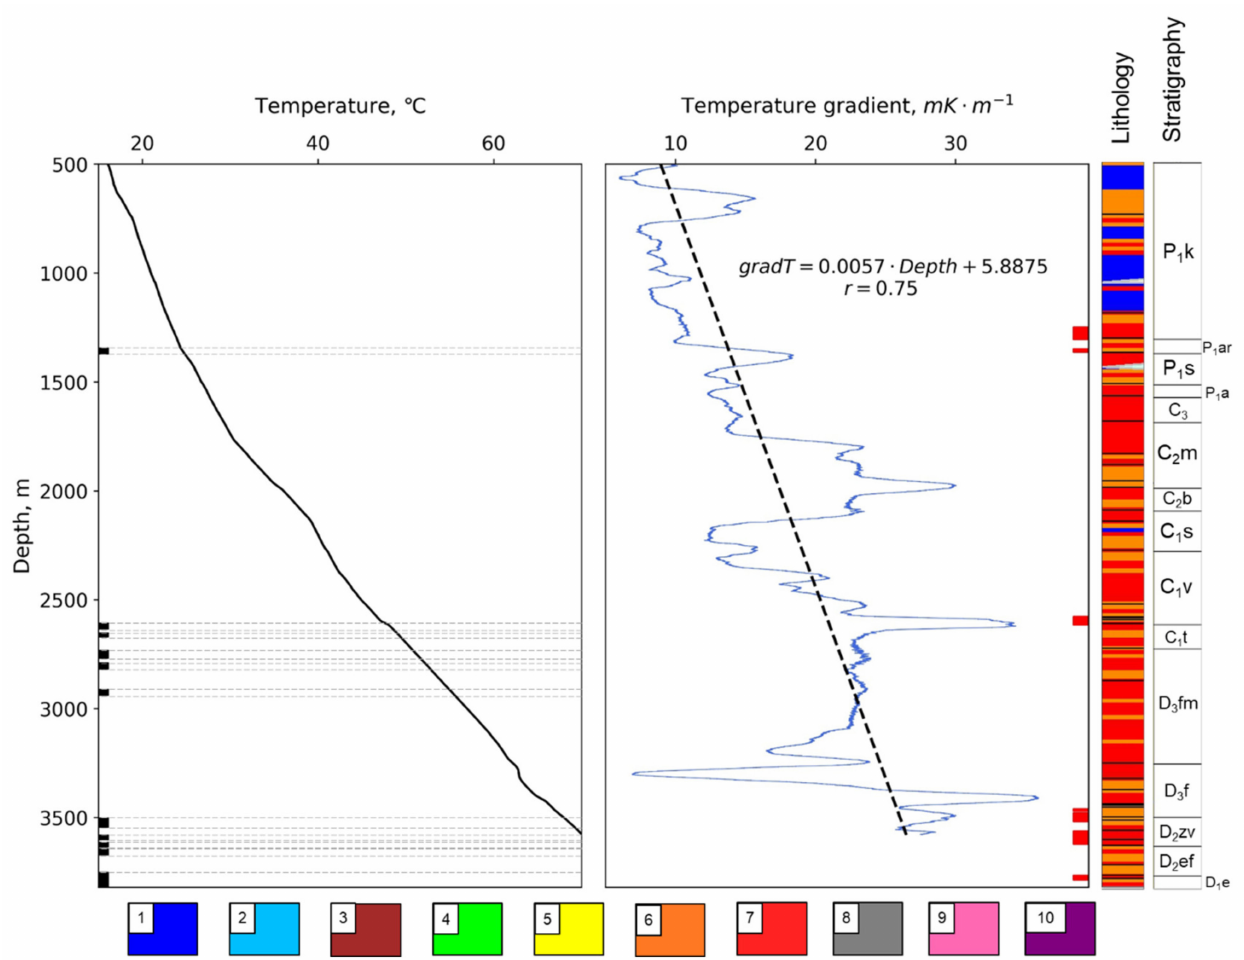
Figure 5. Temperature ( left ) and temperature gradient ( right ) along the well. Black dots on the left panel represent intervals of drilling with coring. Red dots on the right panel represent low well-quality-intervals (cavernous intervals; diameters of caverns exceed 10 cm). Dashed black line on the right panel represents the regression trend for temperature